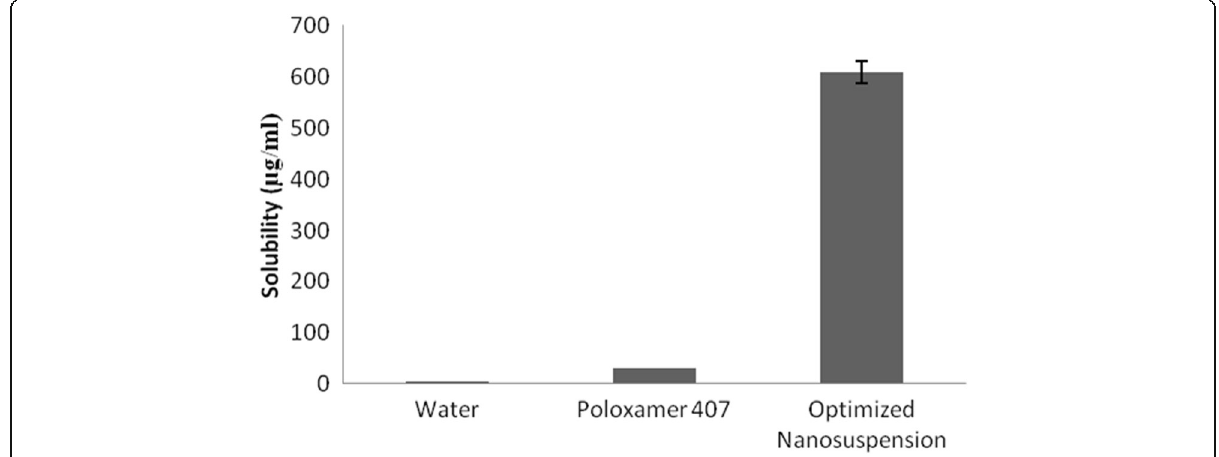
Fig. 10 Saturation solubility studies comparison of irbesartan